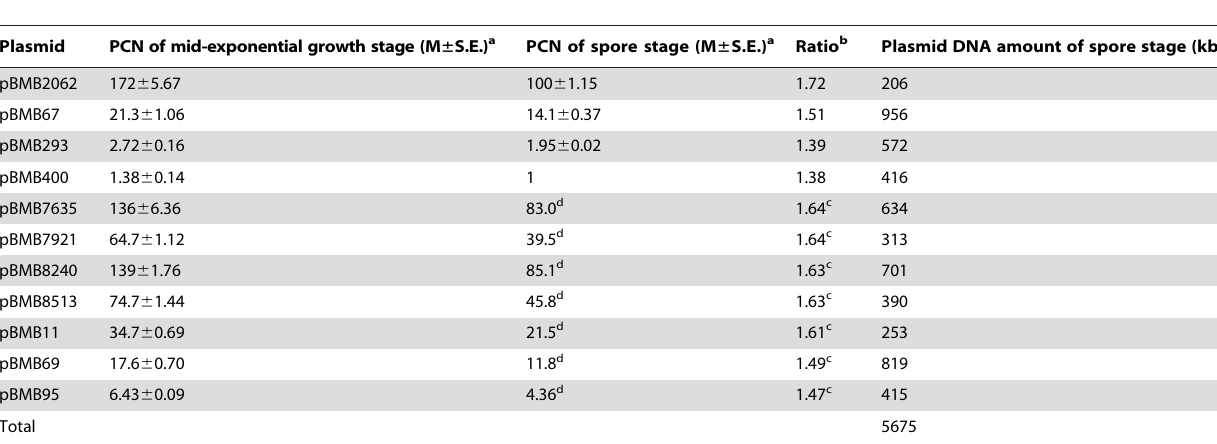
Table 2. The calculated total plasmid DNA amount when bacteria grew to the spore stage.